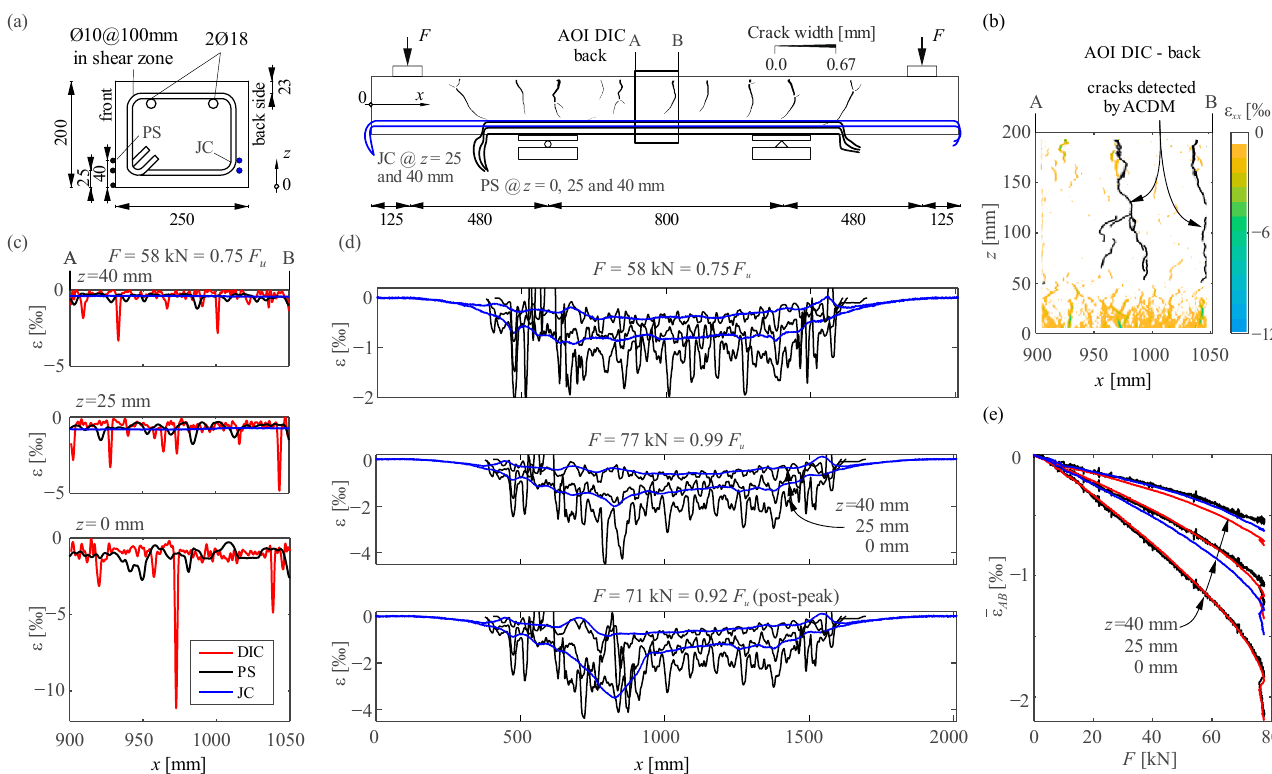
Figure 11. Measurement of concrete compressive strains with DFOS on specimen Nn : ( a ) Geometry, test setup and instrumentation (dimensions in mm) with crack pattern and crack widths at F = 58 kN(JC: cast jacketed FOS; PS: polyimide FOS on surface); ( b ) DIC strains in the longitudinal direction x at F = 58 kN; ( c ) strain results along the field of view of DIC at F = 58 kN; ( d ) complete DFOS strain distributions at F = 58, 77, and 71 kN (post-peak) and ( e ) evolution of average strains within the field of view of DIC.